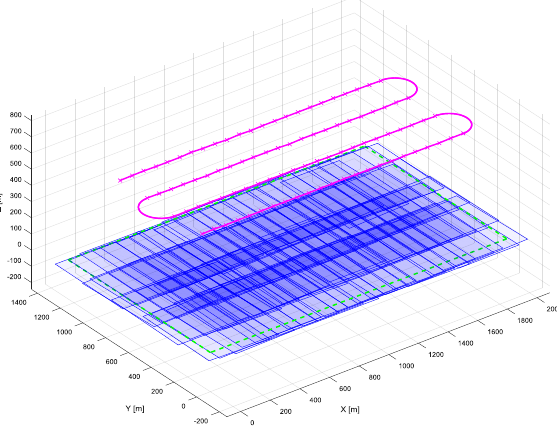
Figure 6. Flight path and image configuration